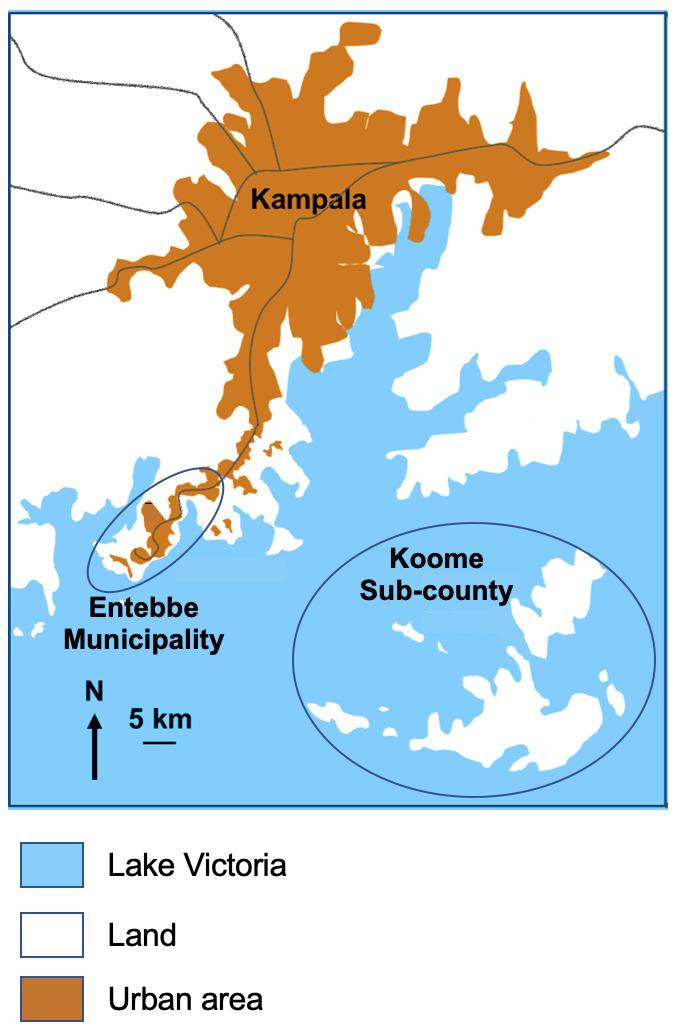
Location of the study areas.